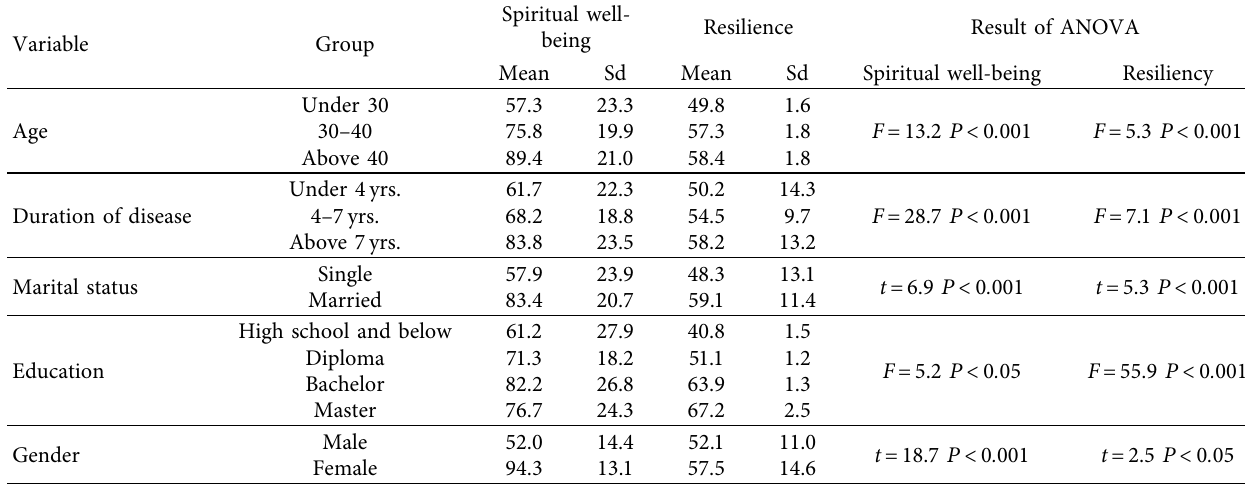
Table 2: Correlations between the participants’ spiritual well-being and resilience with their demographic characteristics ( N � 150). Variable